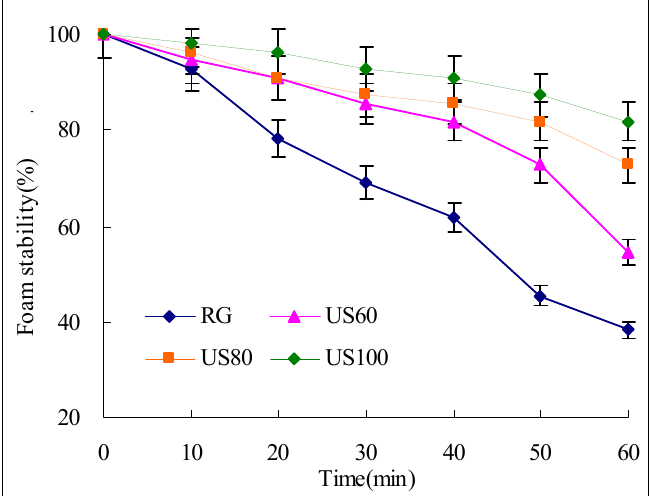
Figure 3. Foam stability of ultrasound treated gluten protein